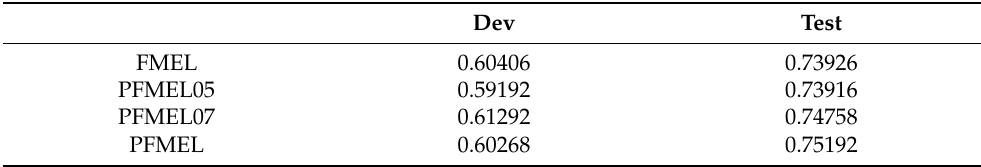
Table 6. Results with different dataset sizes for